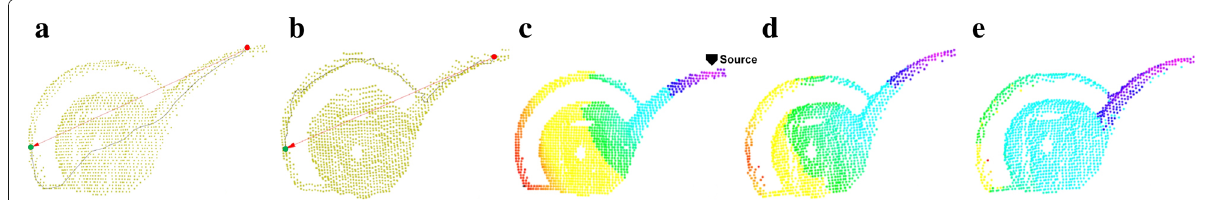
Fig. 13 Geodesics and geodesic distance maps. a Geodesic path ( blackline ) from the source ( redcircle ) to the end ( greencircle ), with no curvature weights on edges ( redline is the Euclidean shortest path). b Geodesic path from source to end with curvature weights on the edges. c Euclidean distance map from source to all the points. d Non-weighted geodesic map from source to all the points. e Weighted geodesic map from source to all the points. The point cloud color follows the magnitude of distance proportional to wavelengths in visible spectrum ( violet (minimum), red